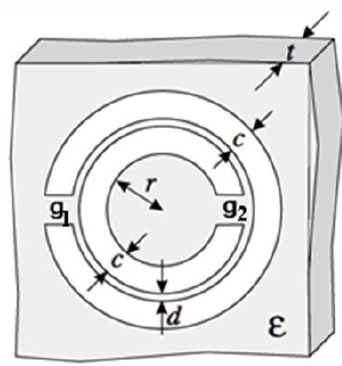
Figure 10. Schematic view of a circular split-ring resonator.